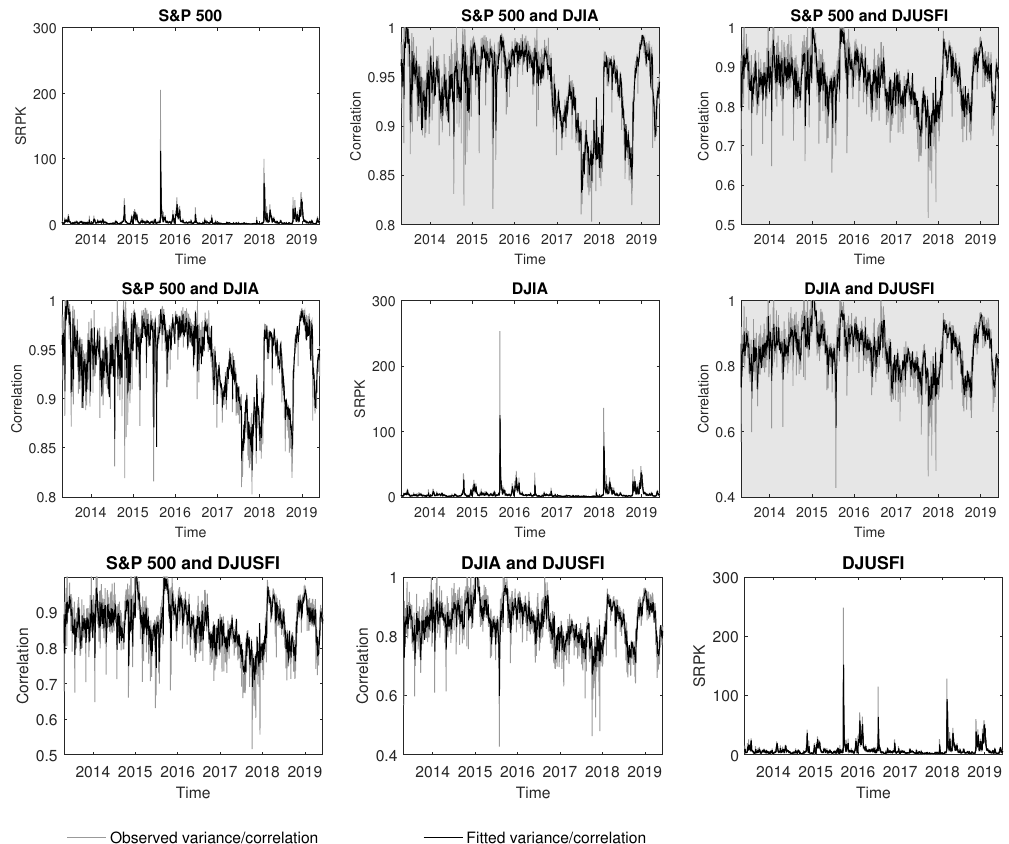
Figure 2. Plots of in-sample fits of variance and correlation using MCARR(1,1,0) and MCARR(1,1,1) (in grey background) models with S&P 500, DJIA and DJUSFI